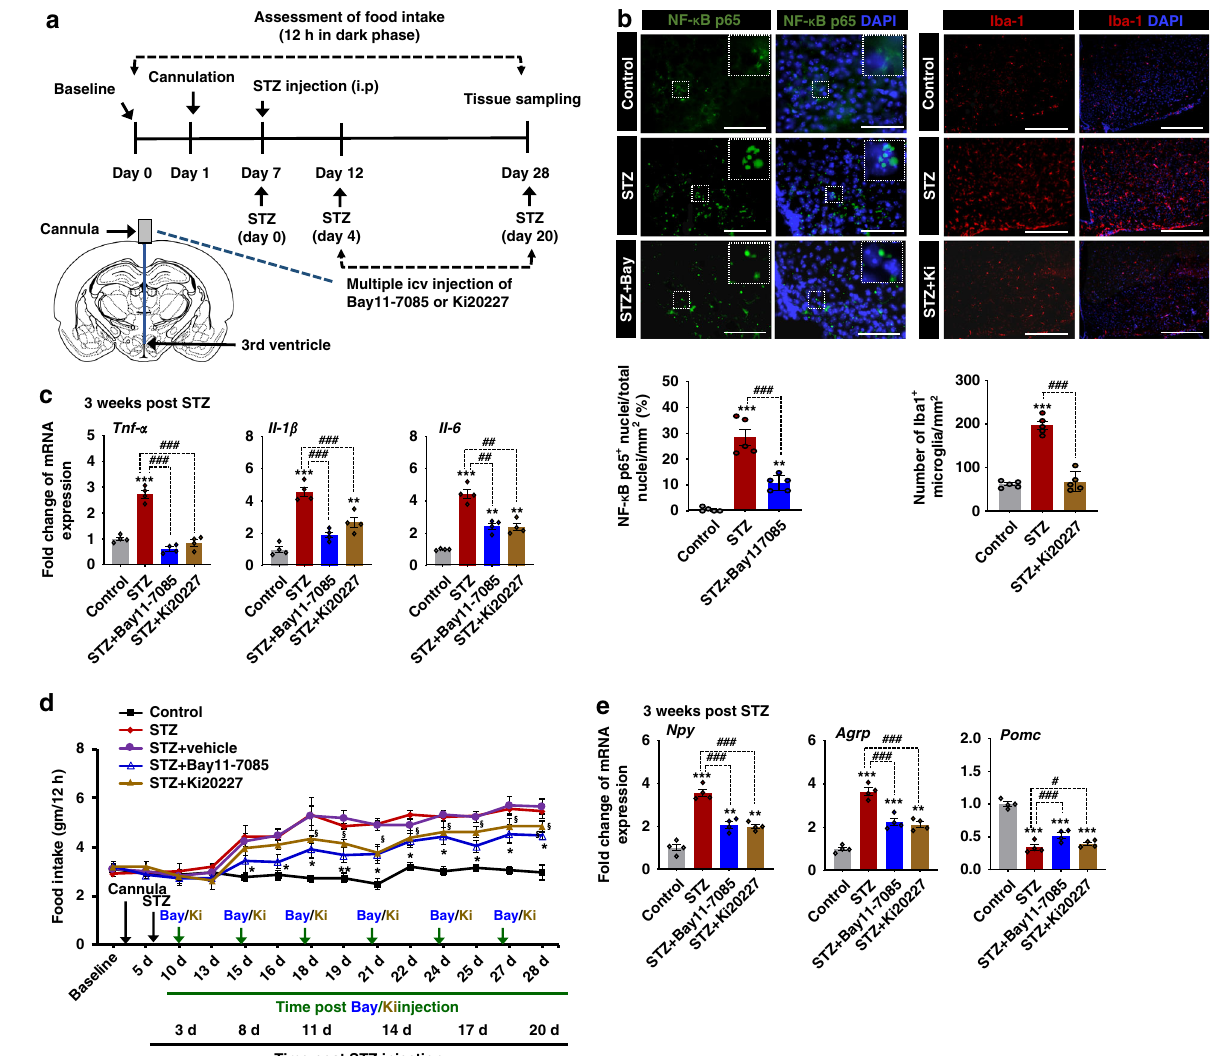
Fig. 3 Effects of pharmacological inhibition of hypothalamic in fl ammation on feeding behavior and expression of food intake-regulating neuropeptides in the diabetic mouse hypothalamus. Bay 11-7085 (an inhibitor of I- κ B phosphorylation, 1 µ g) and Ki20227 (an inhibitor of CSFR1, 1 µ g) solution were administered via multiple icv injections starting from 4 d post-STZ injection to the following indicated time points. The schematic diagram represents the timeline of experimentation and the route of administration of inhibitors ( a ). Immuno fl uorescence analyses show the immunoreactivity of NF- κ B p65 and Iba-1 ( b ) in the hypothalamus at 3 w post-vehicle/STZ injection. Inserts show the translocation of NF- κ B p65 in DAPI-positive nuclei. Quanti fi cation of the percentage of NF- κ B p65-positive nuclei (### p = 9.3E-5, STZ + Bay11-7085) and the total number of Iba-1-positive microglia (### p = 2.5E-7, STZ + Ki20227) per mm 2 are shown in the adjacent images. Microscope data were gathered using six randomly selected fi elds captured at the same magni fi cation. Scale bars indicate 100 µ m (left) and 200 µ m (right). The expression of proin fl ammatory cytokines such as Tnf- α (### p = 6.7E-8, STZ + Bay11-7085; and ### p = 2.5E-7, STZ + Ki20227), Il-1 β (### p = 3.7E-5, STZ + Bay11-7085; and ### p = 0.0008, STZ + Ki20227), and Il-6 (# p = 0.0120, STZ + Bay11-7085; and ## p = 0.0010, STZ + Ki20227) was assessed by real-time RT-PCR ( c ). Food intake (* p = 0.0160, STZ + Bay11-7085; and § p = 0.0323, STZ + Ki20227 at 28 d) was measured ( d ), and the expression of Npy (### p = 0.0006, STZ + Bay11-7085; and ### p = 0.0002, STZ + Ki20227), Agrp (### p = 0.0003, STZ + Bay11-7085; and ### p = 0.0004, STZ + Ki20227), and Pomc (### p = 0.0001, STZ + Bay11-7085; and # p = 0.0110, STZ + Ki20227) mRNA was assessed by real-time RT-PCR ( e ). Results for mRNA expression are displayed as the fold increase of gene expression normalized to Gapdh . * or § p < 0.05 or ** p < 0.01 or *** p < 0.001 versus WT/KO control animals ( b , c , e ) or STZ-injected animals ( d ). One-way ANOVA ( b , c , e ) and two-way ANOVA with Tukey ’ s post hoc test ( d ), n = 5 (b), n = 6 ( d ), and n = 4 ( c , e ); mean ± SEM. Value of “ n ” indicates the number of animals. Source data are provided as a Source data fi le. d day(s); STZ streptozotocin; Bay Bay 11-7085; Ki